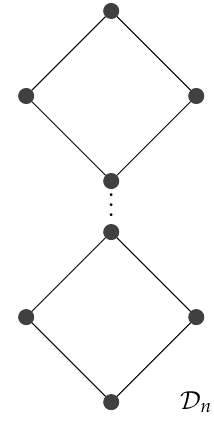
Figure 4. Concept lattices of Example